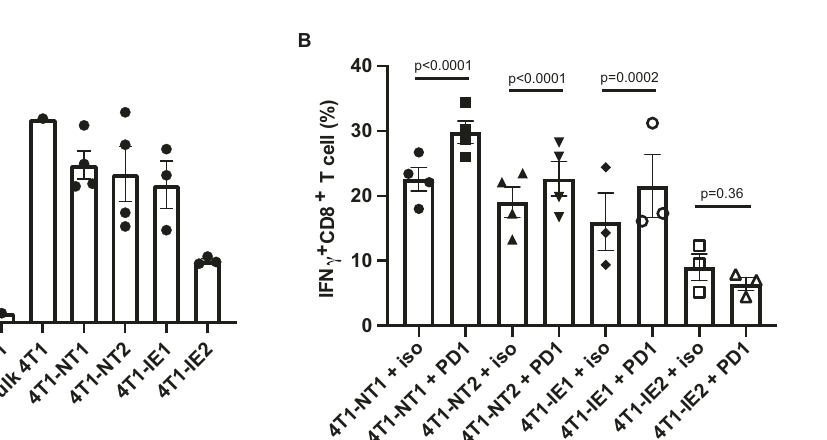
Fig. 6 | The 4T1-IE2 clone can directly suppress cytotoxic T cell activation and prevent further T cell activation by anti-PD1 immunotherapy. A Measurement of intracellular IFN-gamma (IGN γ ) production by 4T1-speci fi c CD8+T cells fol- lowingco-culturewithno4T1cells(No4T1),bulk4T1cells(Bulk4T1)and4T1clonal populations (4T1-NT1; 4T1-NT2; 4T1-IE1; 4T1-IE2). Four independent biological replicatesinNT1andNT2groups,threeindependentbiologicalreplicatesinIE1and IE2 groups and one replicate for no 4T1 and bulk 4T1 groups. Data are shown as